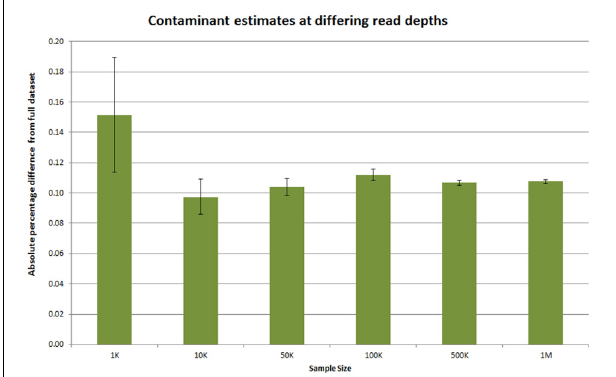
FIGURE 5 | Estimating required read sampling for contaminant checks. Ten million reads from an Illumina RNA-seq dataset was subsampled at various numbers of reads. The number of rRNA contaminant reads in this dataset was 1.86% when calculated over the full dataset. The absolute percentage difference at different sub-sample sizes was calculated for 500 replicates at each depth and the average shown. The error bars indicate the 95% confidence interval for the absolute percentage difference.